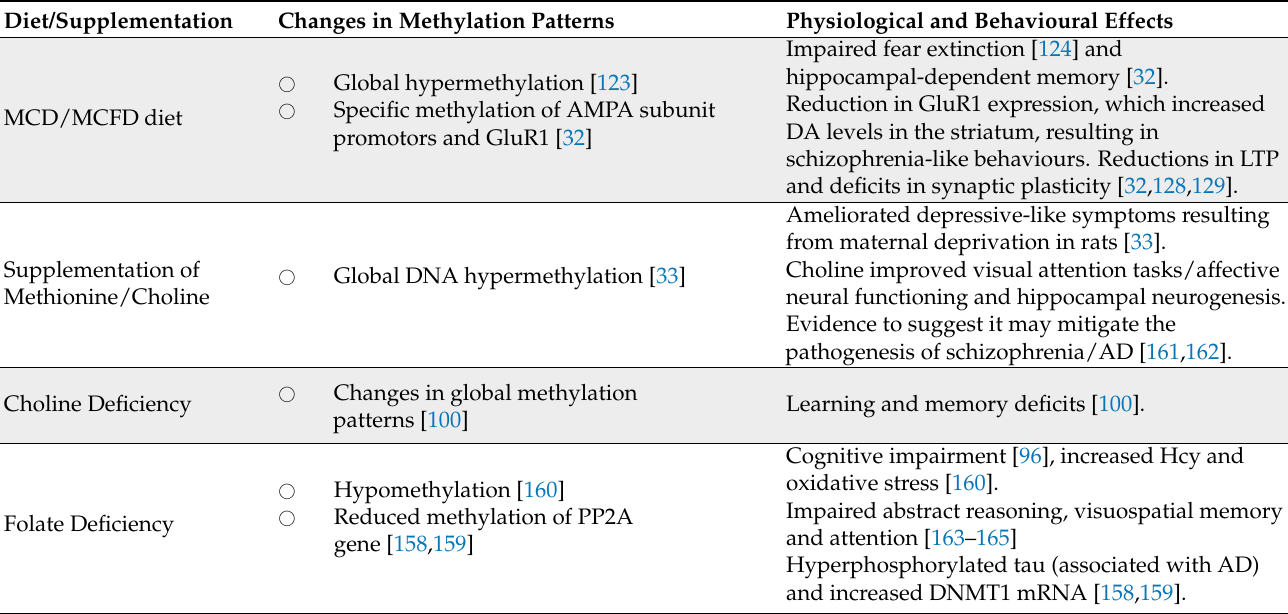
Table 1. Different dietary regimes and their effects on DNA methylation and the resulting changes in the brain. Abbrevia- tions: AMPA, amino-3-hydroxy-5-methyl-4-isoxazolepropionic acid receptor; GluR1, glutamate receptor 1; DA, dopamine; LTP, long-term potentiation; AD, Alzheimer’s disease; PP2A, protein phosphatase; Hcy, homocysteine; DNMT, DNA methyl- transferase; DAT, dopamine active transporter; D1R/D2R, dopamine 1/2 receptor; BDNF, brain-derived neurotrophic factor; CDK5, cyclin-dependent kinase 5; Tph1A, tryptophan 5-monooxygenase; PPAR α , peroxisome proliferator-activated receptor